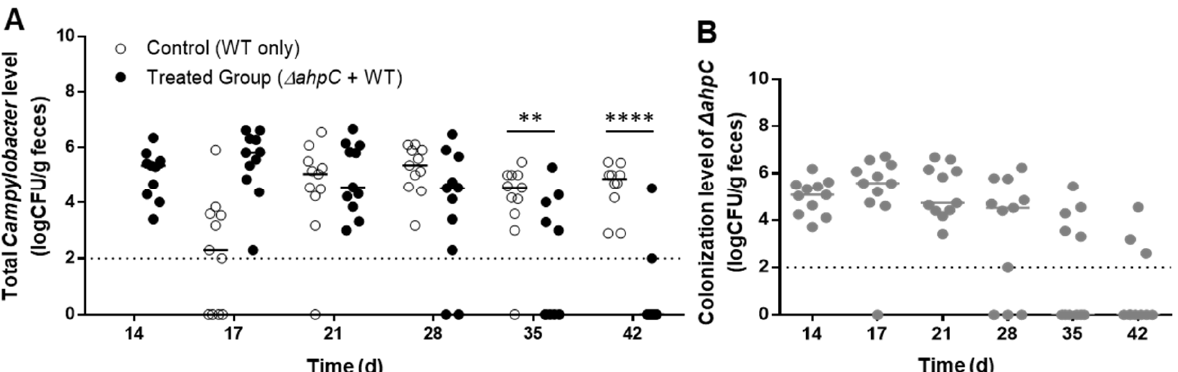
Figure 2. Efficacy of preventing C. jejuni colonization in chickens by exposure to a high dose of the ∆ ahpC mutant. ( A ) Levels of chicken colonization of the total C. jejuni including the wild type and the ∆ ahpC mutant. ( B ) Colonization levels of the ∆ ahpC mutant. Day-old chicks were administered with a high dose (5 × 10 8 CFU/bird) of the Δ ahpC mutant on day three and challenged with the wild-type C. jejuni on day 10. Median values are indicated with lines. Statistical significance was calculated with two-way ANOVA with Sidak’s multiple comparison test (**: p < 0.01, ****: p < 0.0001). The dotted line is the detection limit.